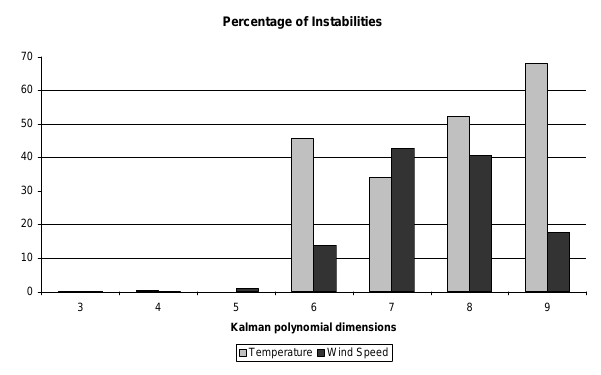
Fig. 3. Percentage of instabilities resulting by remarkably increased values of coefficients for different Kalman filter polynomials in a time series of one year for air temperature and wind speed